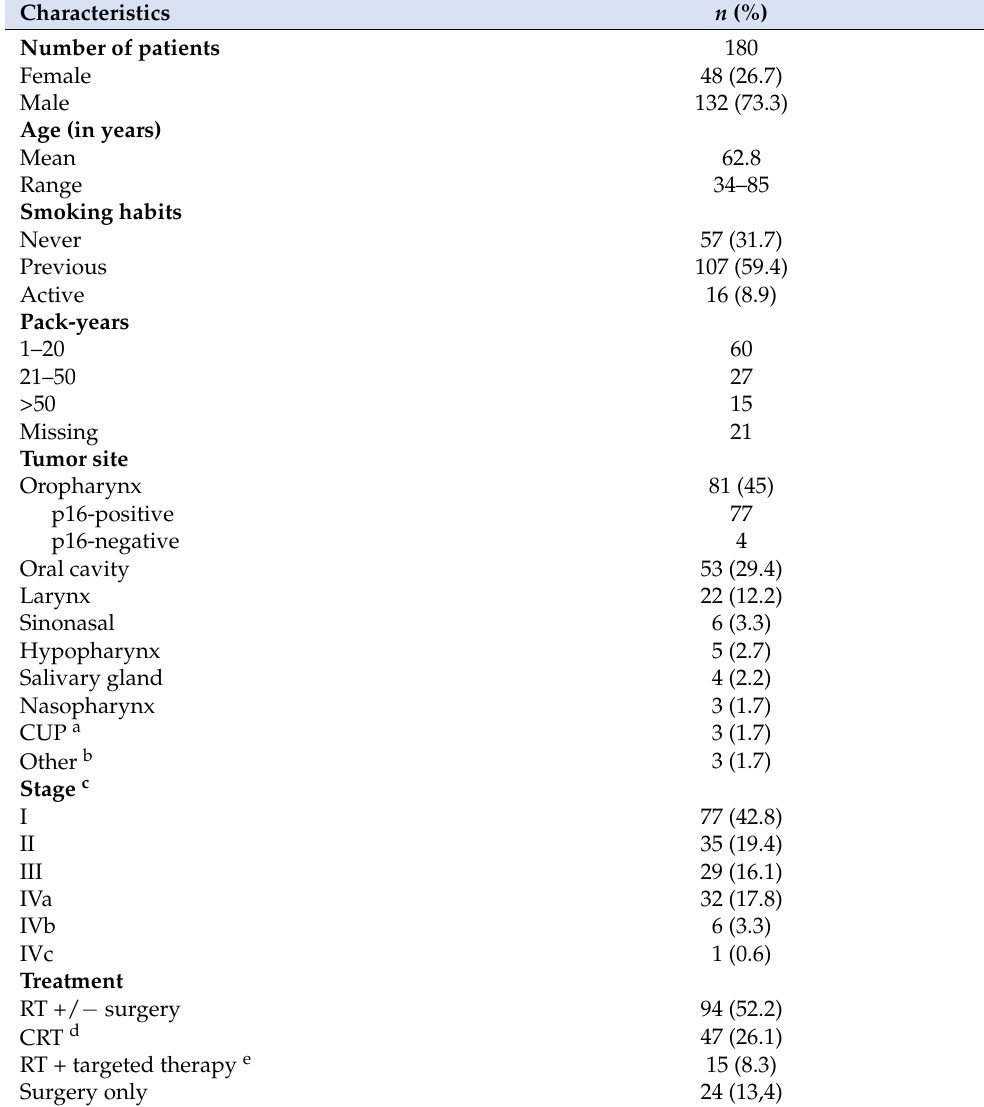
Table 3. Patient